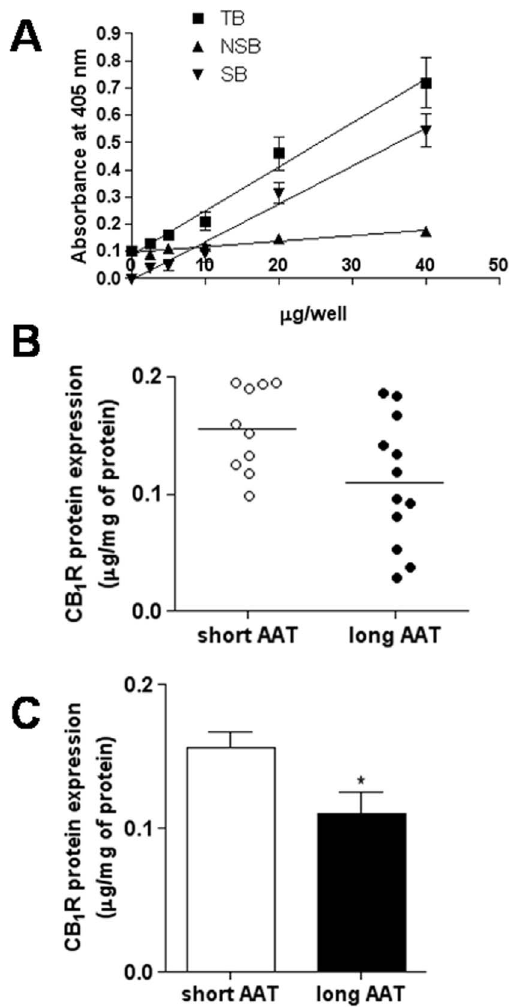
Figure 1. CB 1 R protein expression in MS lymphocytes. A. Calibration curve of the ELISA test with different concentrations of CHO- CB 1 cell extracts. Specific binding (SB) of anti-CB 1 antibody to CHO-CB 1 cell extracts followed the equation y=0.01133 6 + 0.01951 (R 2 =0.9775). B. Dispersion graphs of CB 1 protein content in human lymphocytes from short AAT group (white circles and bar) and long AAT group (black circles and bar) of patients. C. Histogram of cumulative data shown in panel B. *p=0.0335.